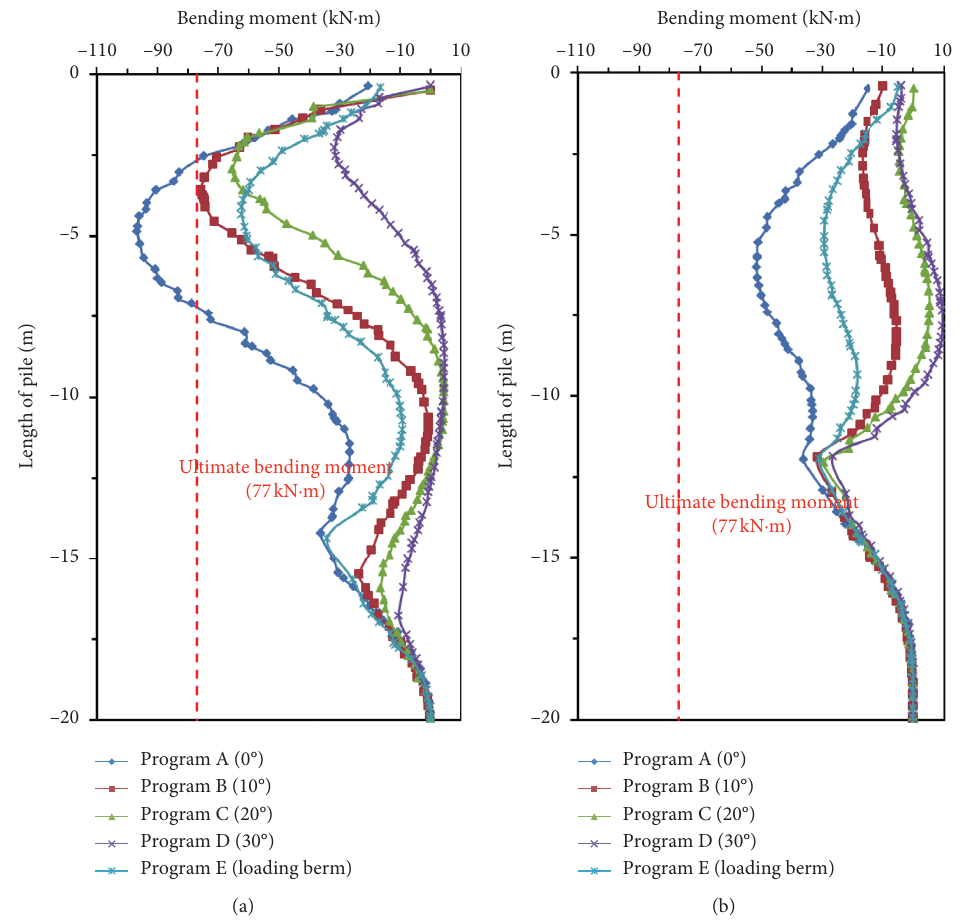
Figure 13: Bending Moments of PCP piles. (a) Pile A and (b) pile B.